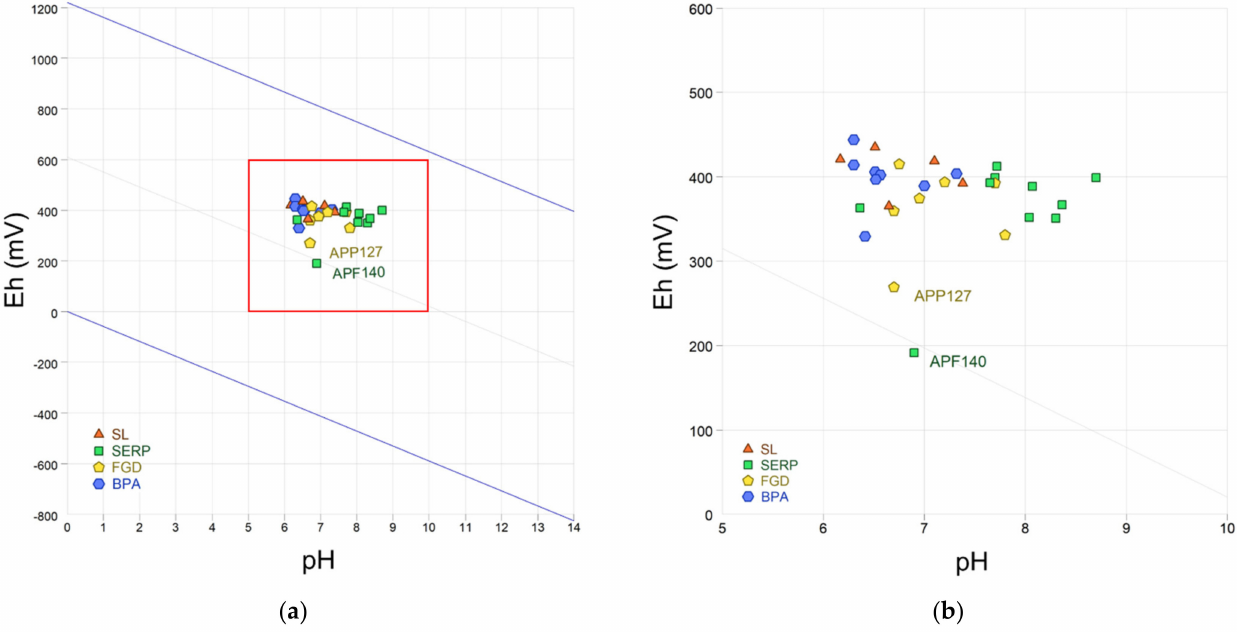
Figure 2. Eh–pH diagrams: ( a ) full plot, where the blue lines indicate the stability field of liquid water; ( b ) an enlargement of the portion indicated in